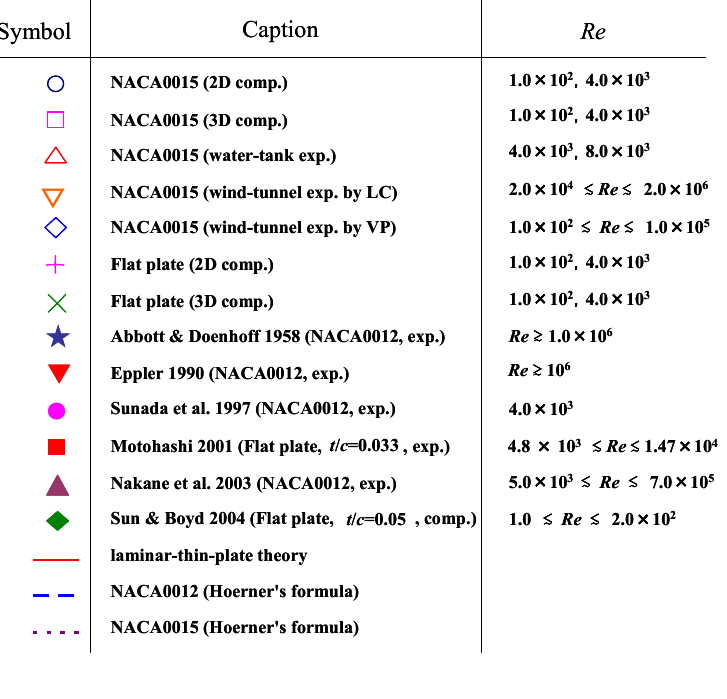
Table 1 Symbols in Figs. 5 and 6, with corresponding values of Re .